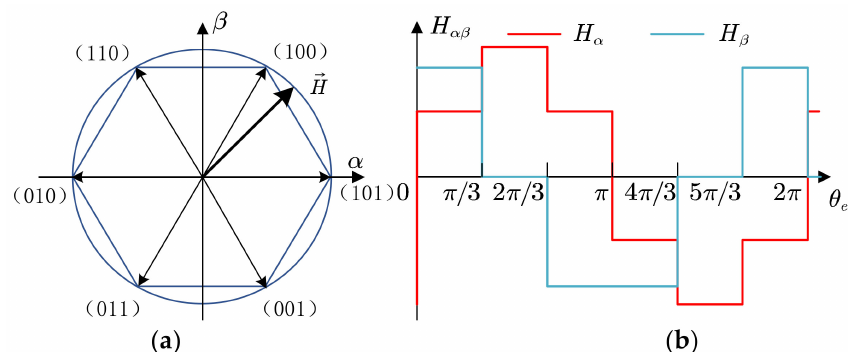
Figure 6. ( a ) Discrete Hall position vector; ( b ) Two orthogonal components.